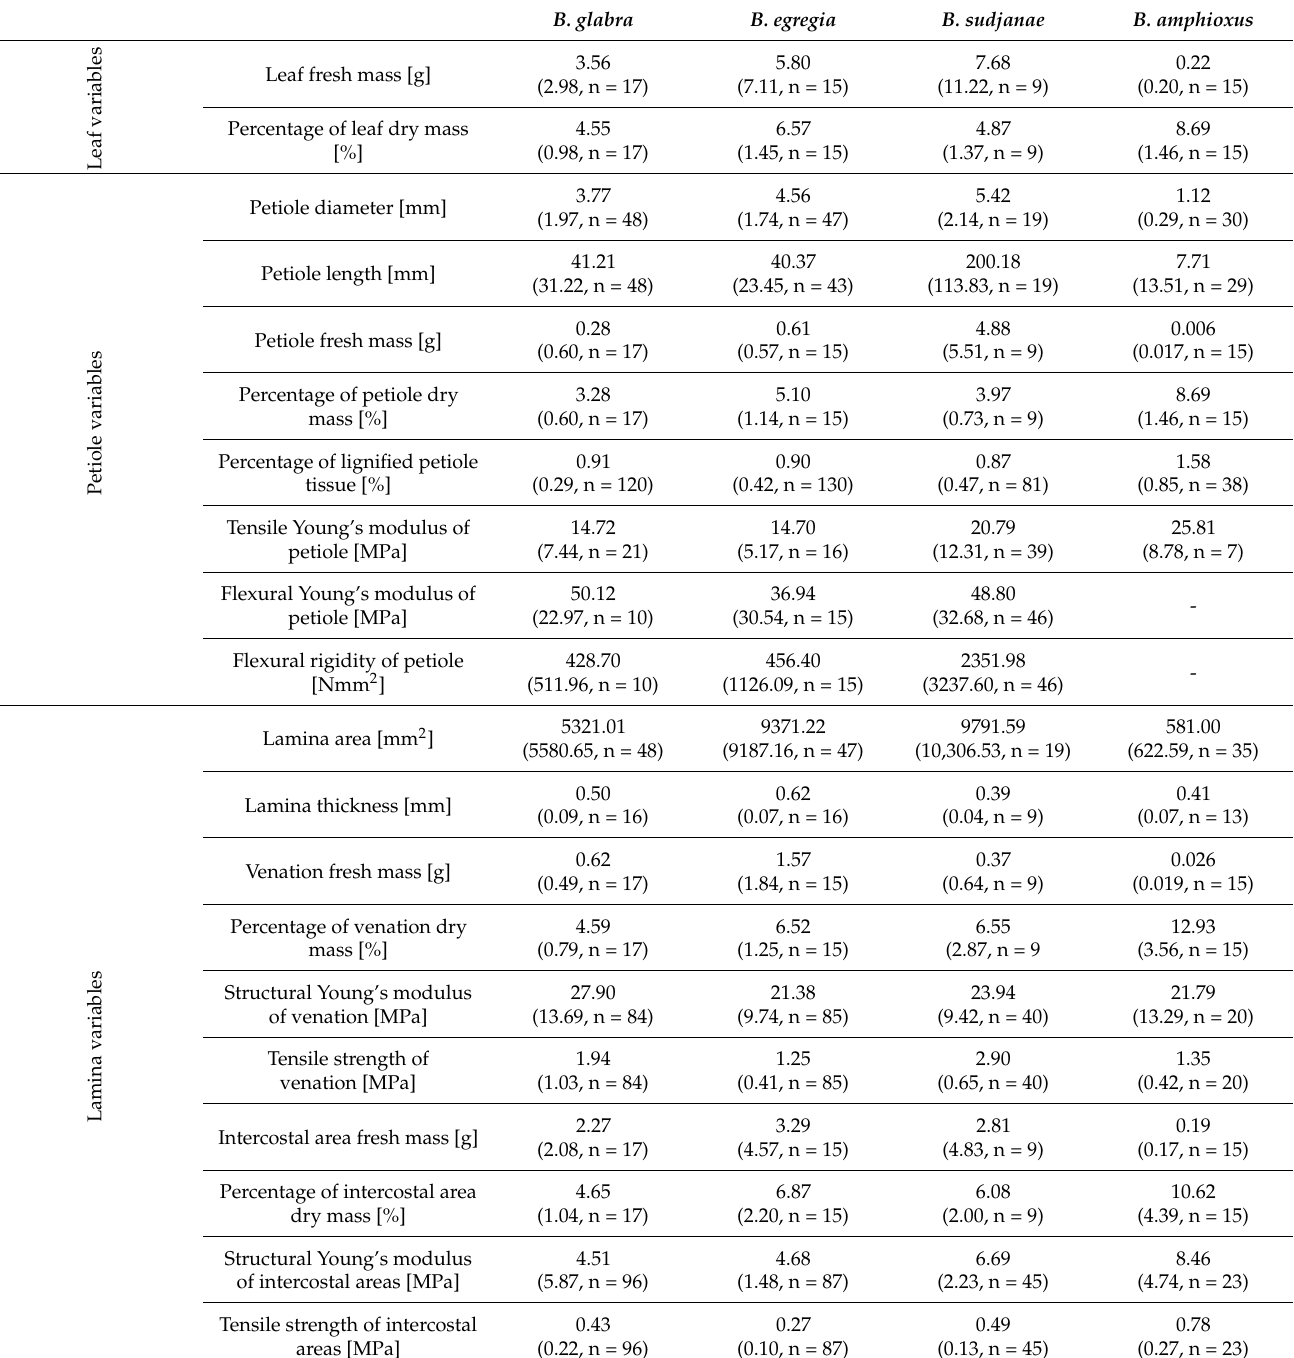
Table 1. Median values of measured leaf variables of the different Begonia species. Interquartile range and sample size (n) are given in brackets. Leaf variables refer to measurements taken from the whole leaf (including petiole and lamina). Petiole and lamina variables show measurements of only petiole or lamina, respectively. All samples were taken from one plant per species (two for B. sudjanae